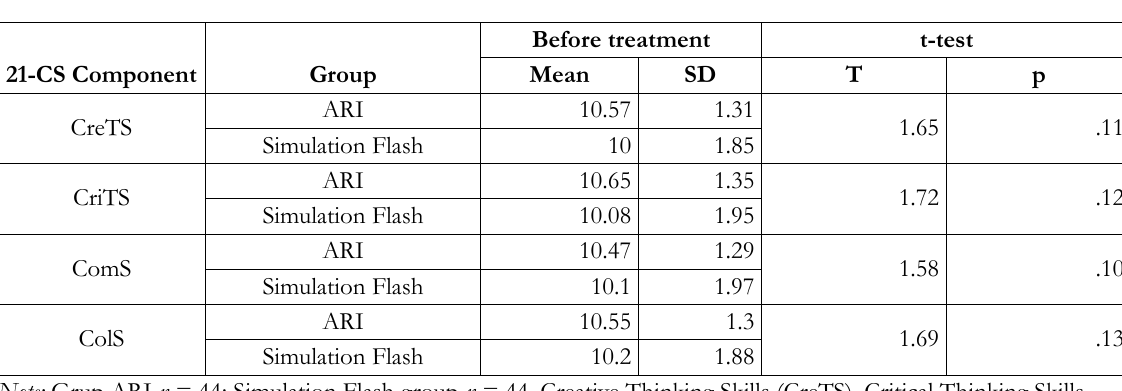
Table 1. T-test scores in 21 st -CS of the control and experimental group